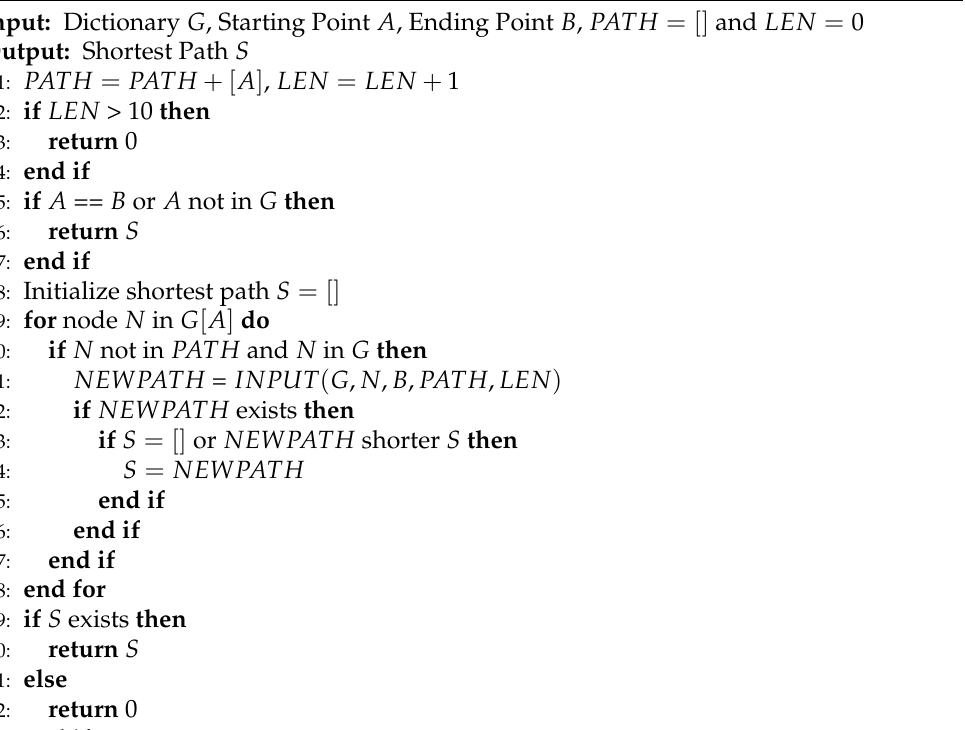
Algorithm 1 Shortest-path